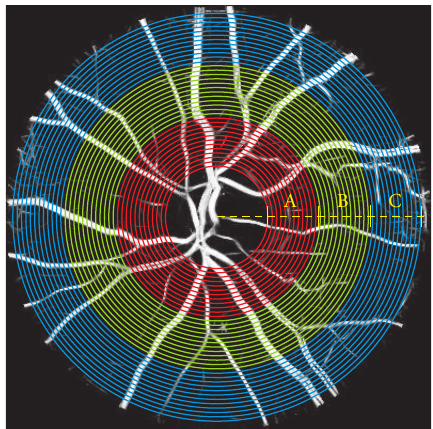
Figure 3: Representation of three major zones, A (red), B (green), and C (blue) around the OD with respect to one to three OD radius from OD boundary and circular scanning in the defined